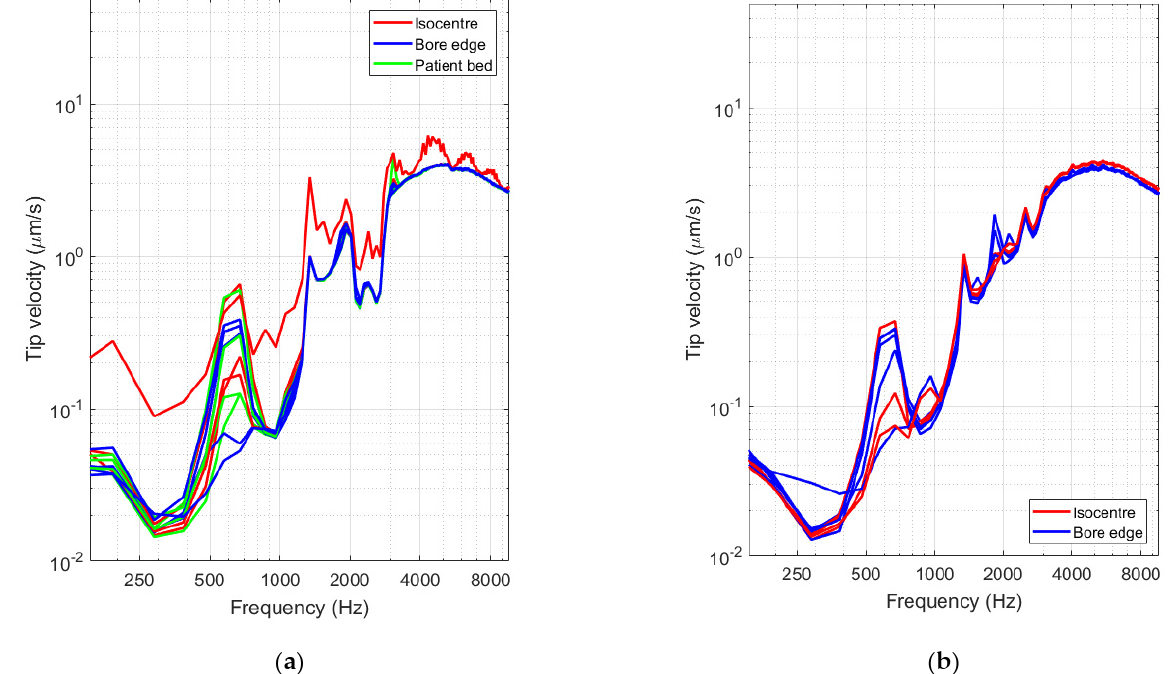
Figure 18. ( a ) Spectra of the signals in µm/s. Datasets are grouped per test location, showing signals when the actuator was located in the scanner isocenter (red solid line), at the end of the bore on the patient bed (green) and right next to the scanner bore opening (blue). ( b ) Spectra acquired for signals acquired on the second experimental campaign. Color coding is identical as in panel ( a ).